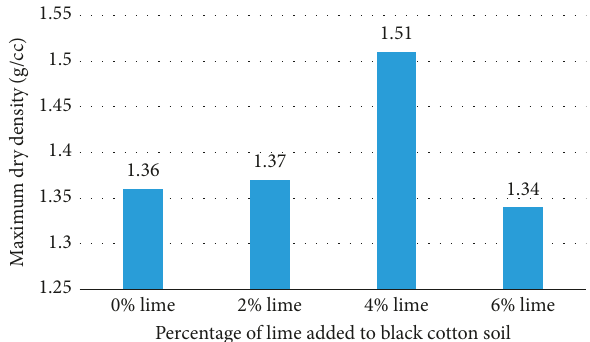
Figure 2: Variation of maximum dry density with varying per- centage of lime.